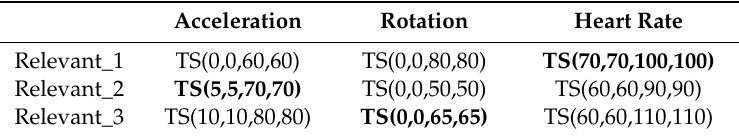
Table 8. Evaluation of relevant with three trapezoidal functions.